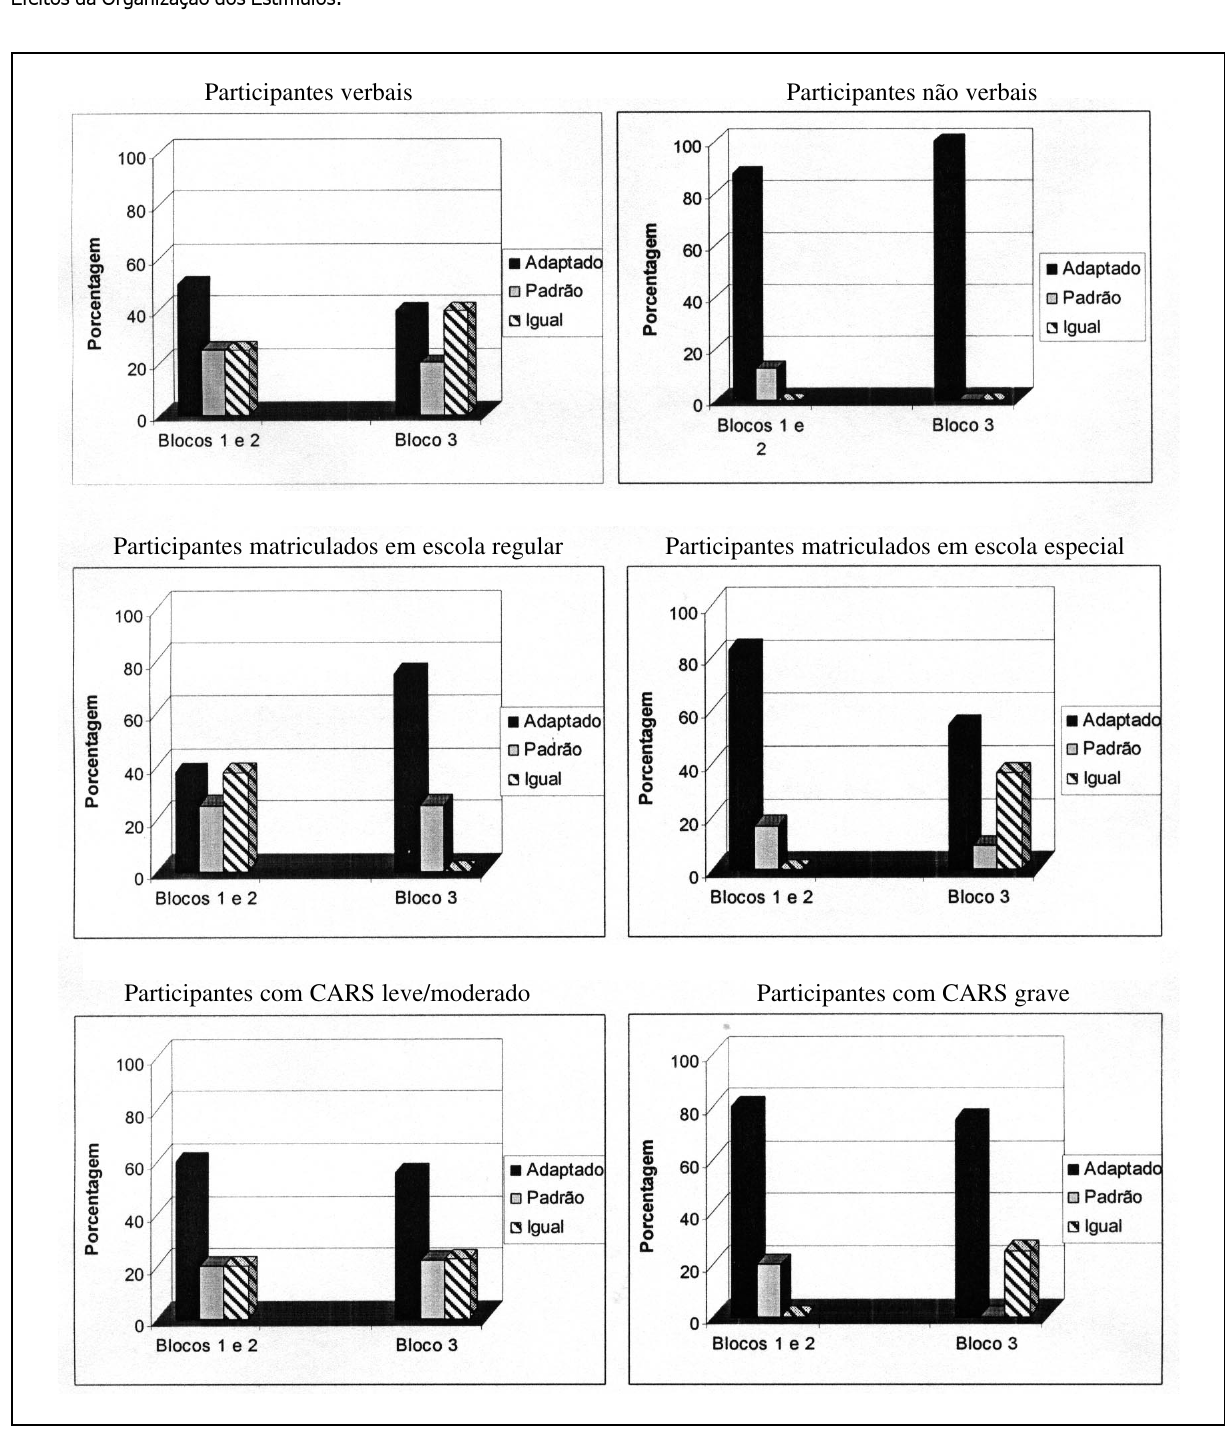
Figura 4. Distribuição porcentual de participantes com mais acertos no matching adaptado, mais acertos no matching típico ou mesmo número de acertos nos dois arranjos, em função do repertório verbal, do tipo de escola e da pontuação na